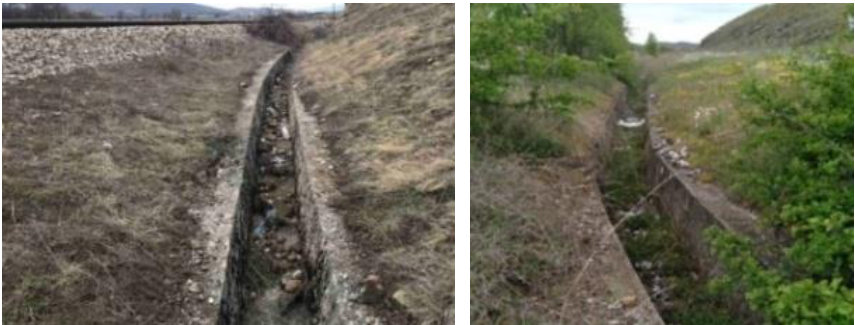
Figure 6. Types of